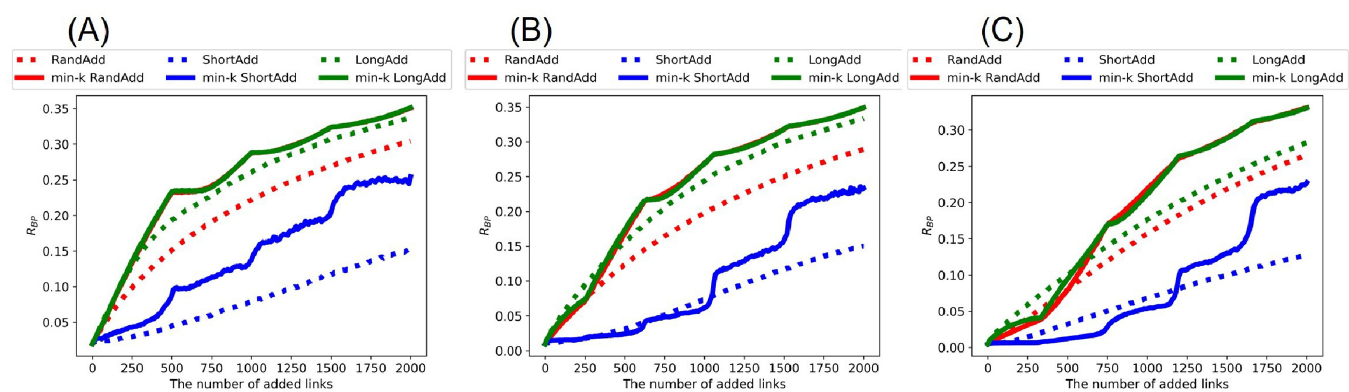
Fig 3. Robustness index against the worst-case BP attacks after adding links to random trees. The min- k RandAdd and min- k LongAdd methods (red and green solid lines) are the most effective for improving R BP . For small numbers of added links less than (A) 130, (B) 380, and (C) 540, the LongAdd method (green dotted lines) is higher than other five methods. The initial random tree has (A) narrower, (B) exponential, and (C) power-law degree distributions. The correspondence between lines and methods is the same as in Fig 2.